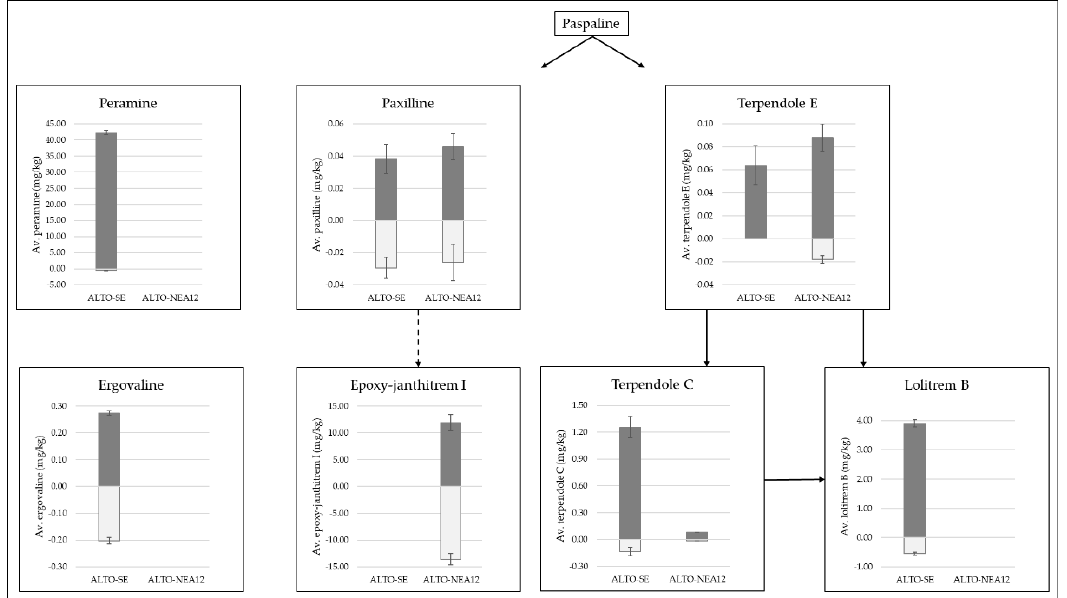
Figure 3. Distributions of peramine and ergovaline alkaloids as well as intermediates and end products of the indole diterpene pathway (paxilline, epoxy-janthitrem I, terpendole E, terpendole C and lolitrem B), as measured in Alto-SE- and Alto-NEA12-infected perennial ryegrass shoots (dark-grey bars) and roots (light-grey bars). Concentrations were measured using the same matrix-matched standards. Solid arrows represent clear pathways according to KEGG metabolic pathway analysis [51–53], whilst the dashed arrow represents the tentative pathway to epoxy-janthitrem I synthesis according to Ludlow [18].